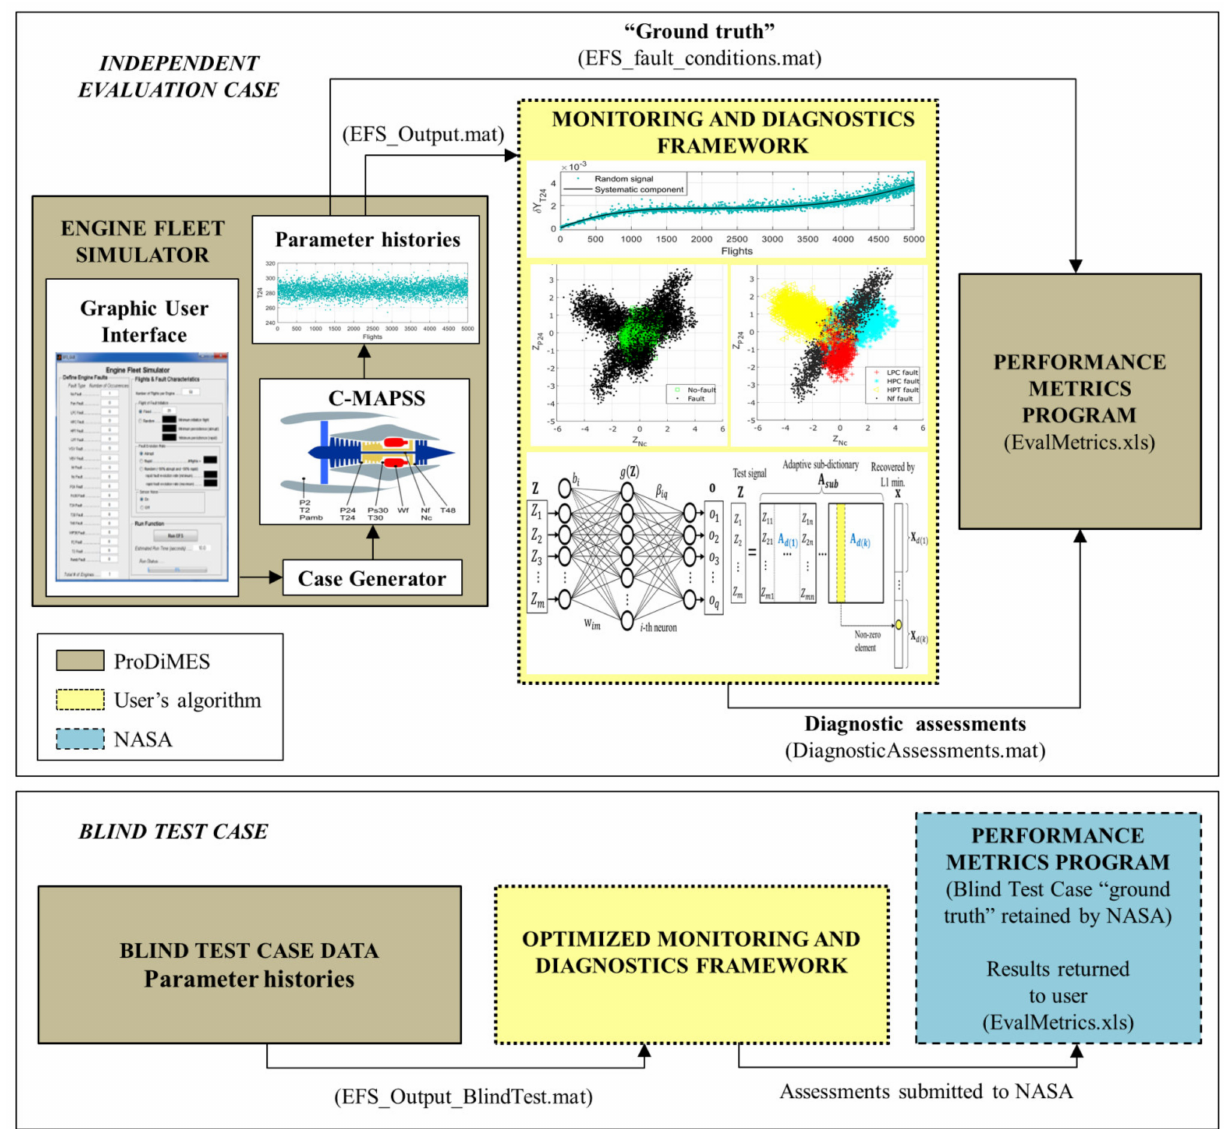
Figure 1. ProDiMES benchmarking